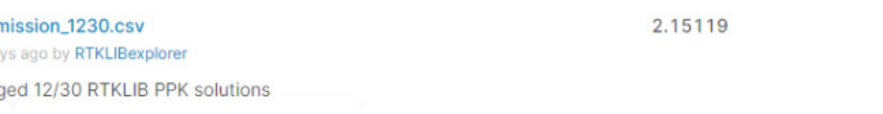
Figure 4. Screenshot of the official Kaggle private leaderboard results for the proposed RTKLIB PPK solution.